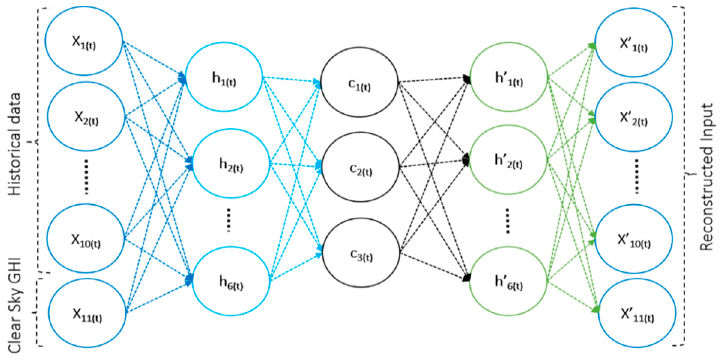
Figure 6. AE training model on solar radiation input data.